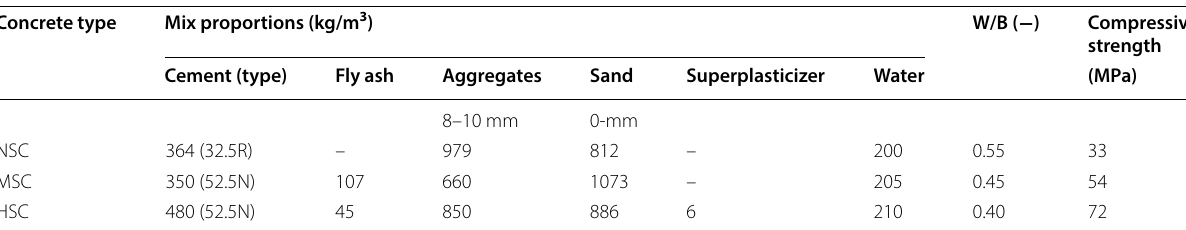
Table 2 Mix design of mixtures. Concrete type